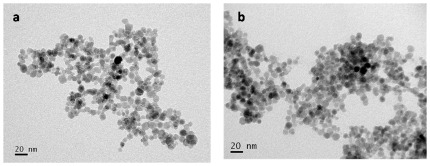
TEM image of SPIONs (
Fig. 2a
) and Tf-SPIONs (
Fig. 2b
), respectively.